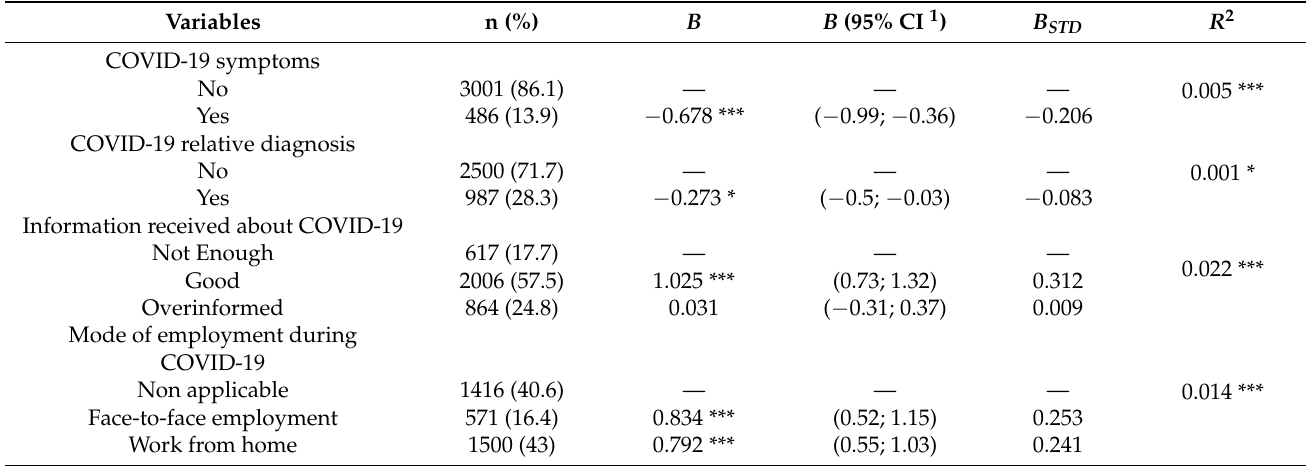
Table 3. Association between COVID-19 variables and peace and